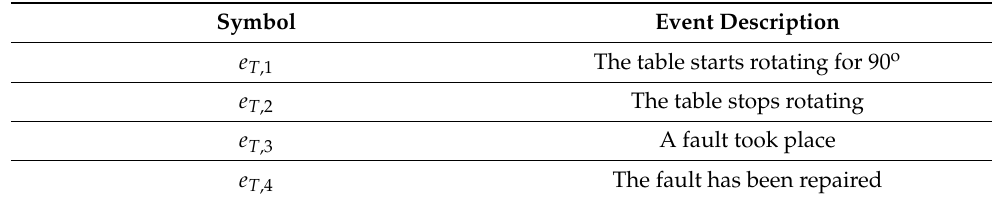
Table 1. States of the circular rotating table. Symbol State Description q T ,1 The table is idle q T ,2 The table is moving q T ,3 The table is in faulty mode